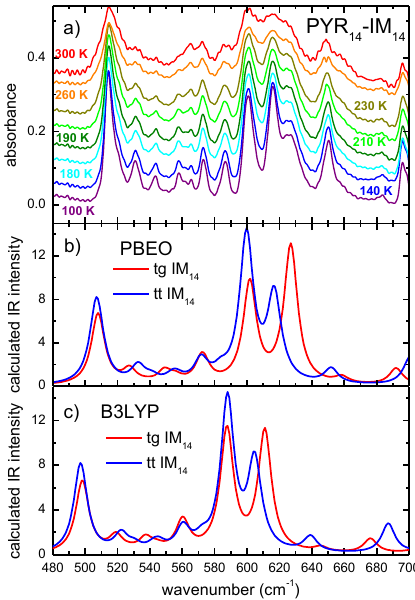
Figure 3. Comparison between the experimental temperature dependence of the absorbance of the PYR 14 -IM 14 ( a ) and the calculated absorptions of the two IM 14 conformers (results from PBE0 model in ( b ) and from the B3LYP model in ( c ) in the frequency range between 550 and 700 cm −1 .